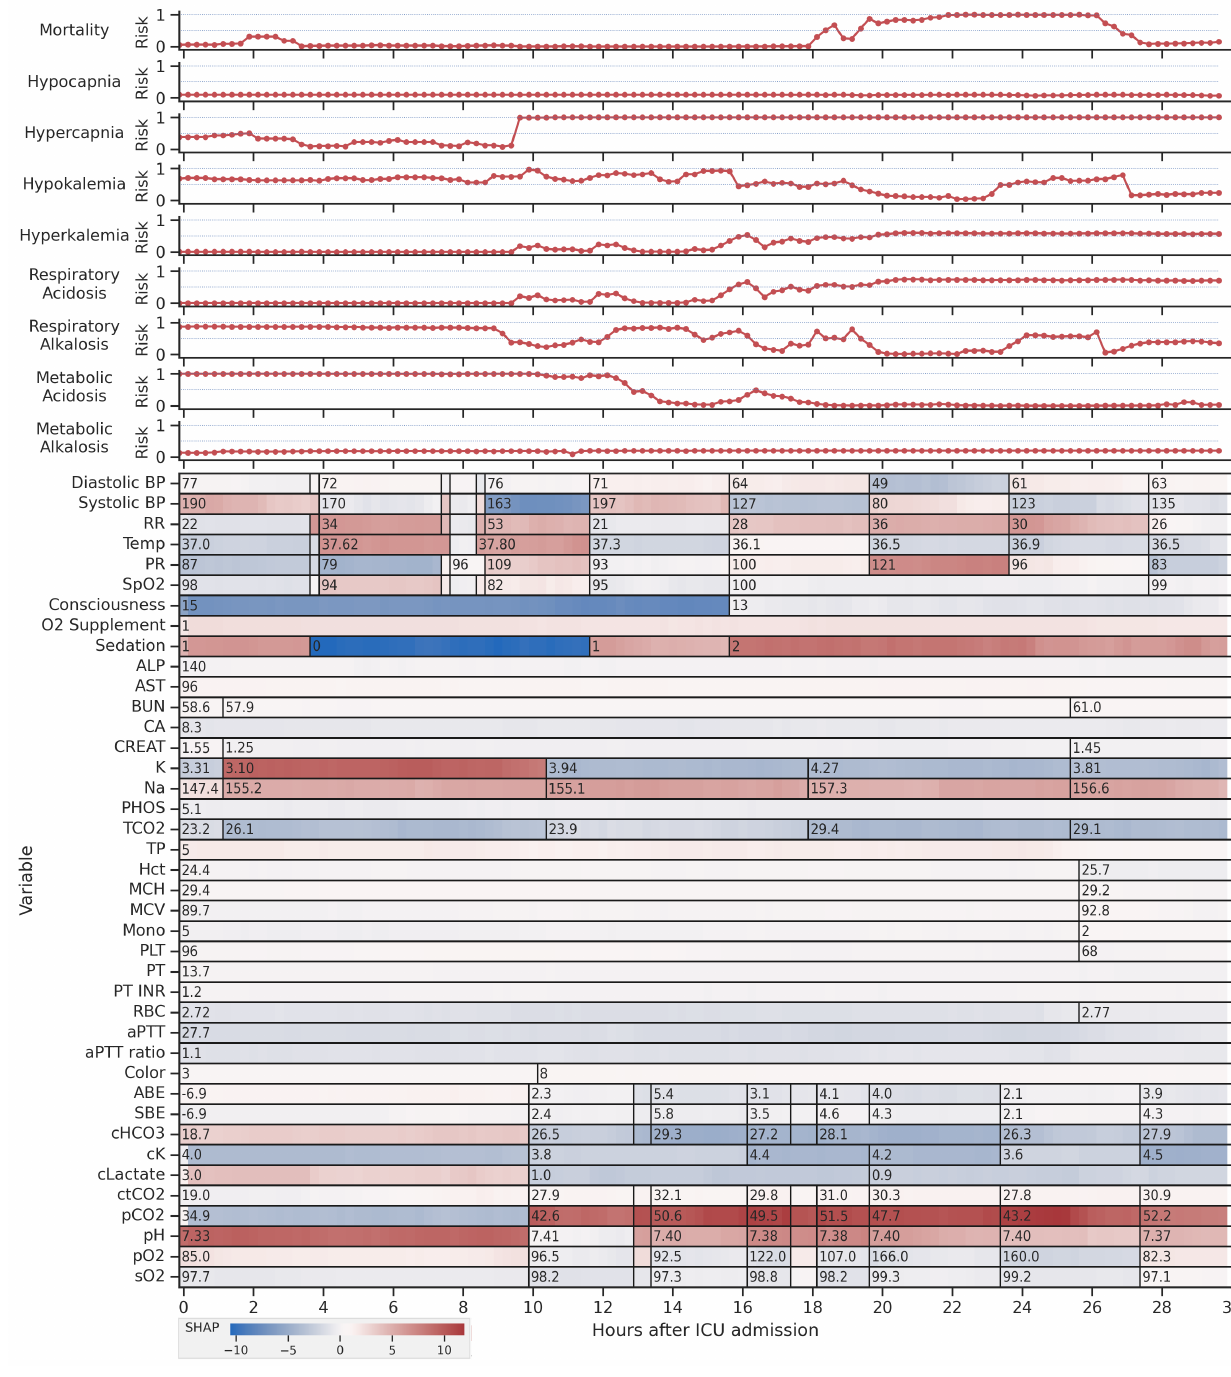
Figure 9. Feature visualization of one sample patient in the test set with model outputs provides valuable insights into how the models are making predictions based on the clinical data. By trans- forming the raw data into time series with a fixed 15 min interval and fill forward imputation, the models can analyze patterns over time and predict the patient’s score for the clinical condition. The models can also flag variables outside their normal range, indicating areas requiring attention from clinicians. It is worth noting that only the top 40 most important clinical variables are shown, and some measurements are skipped due to space limitations. Overall, the feature visualization with model outputs is a powerful tool for understanding how the models are making predictions and identifying areas where clinicians can take action to improve patient